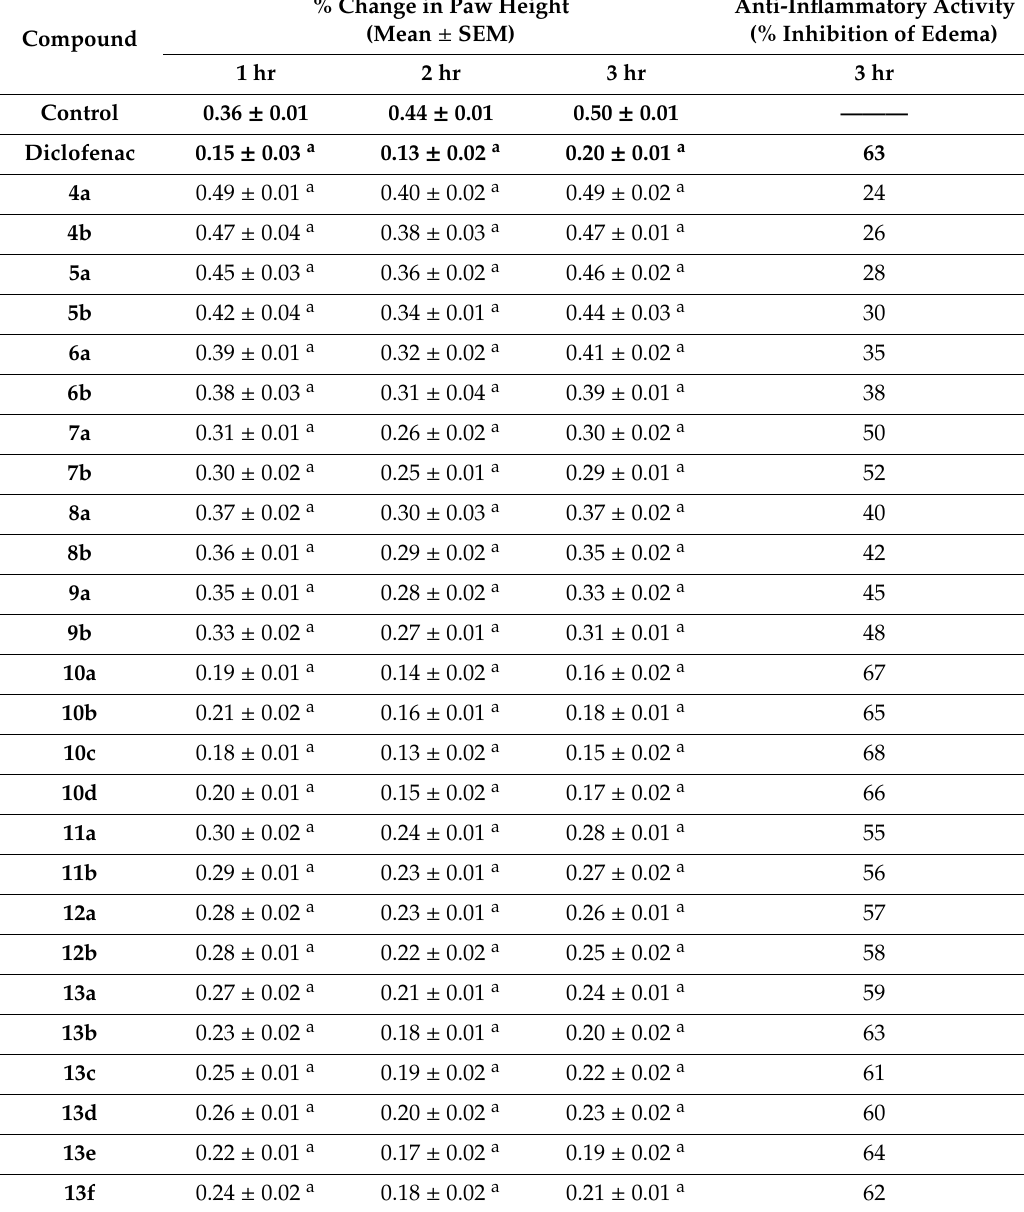
Table 3. Percentage change and inhibition in rat paw height after carrageenan-Induced paw edema in rats.